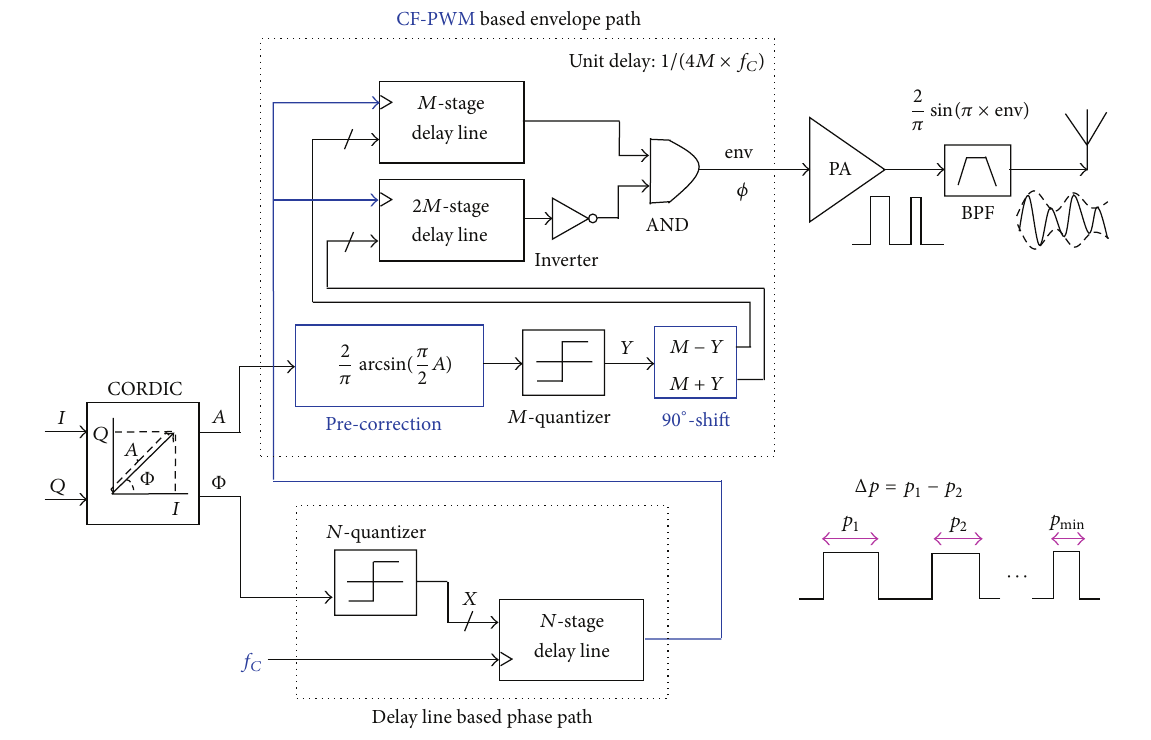
Figure 4: Proposed delay-line based CF-PWM mode for fully digital transmitter.